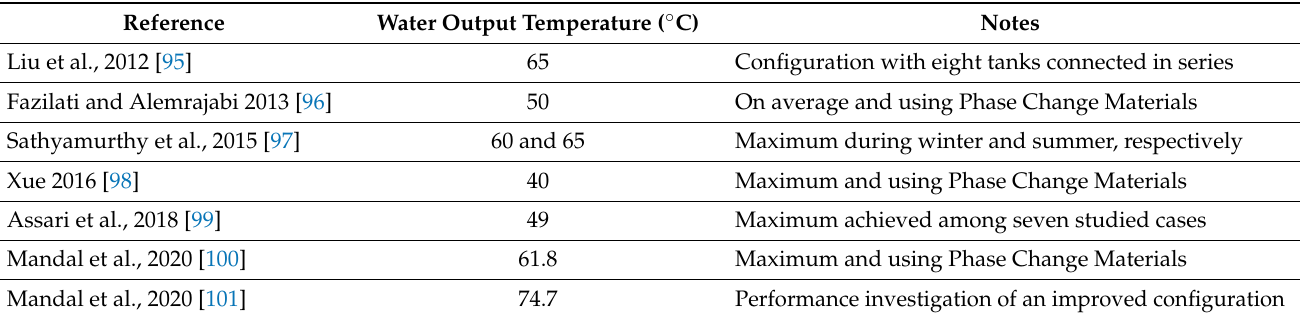
Table 8. Literature review of the values for Solar Water Heater selected